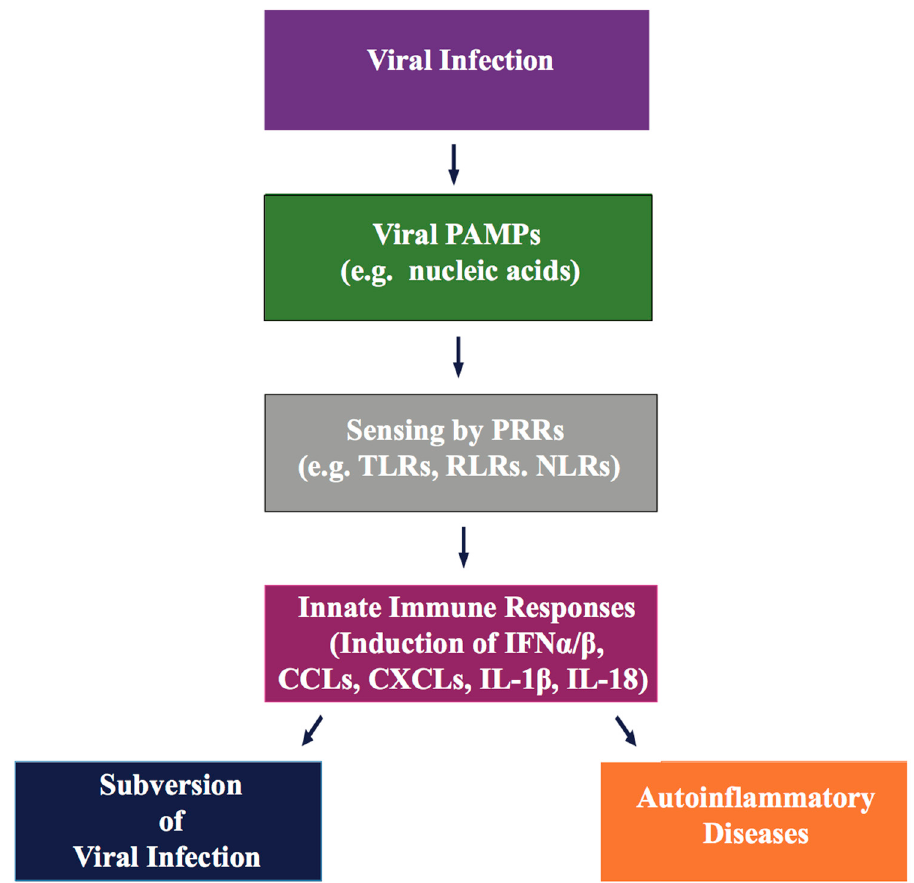
Figure 2. Schematic representation of the key principles involved in innate immune recognition by host pattern recognition receptors (PRRs). Upon viral infection, viral pathogen-associated molecular patterns (PAMPs), such as the viral genome or gene products are recognized by several cellular PRRs present on the cell membrane, in the cytoplasm or within intracellular compartments. Sensing of PAMPs by PRR triggers PRR-mediated signaling pathways and activates antiviral responses, leading to subversion of the infection. Abnormal activation of PRRs may also trigger auto-immunity. Abbreviations: TLRs, Toll-like receptors; NLRs, nucleotide oligomerization domain (NOD)-like receptors; RLRs, retinoic acid-inducible gene I (RIG-I)-like receptors; IFN- α / β , type-I interferons α / β ; CCLs/CXCLs, chemokine ligands; IL-1 β /IL-18, inflammatory